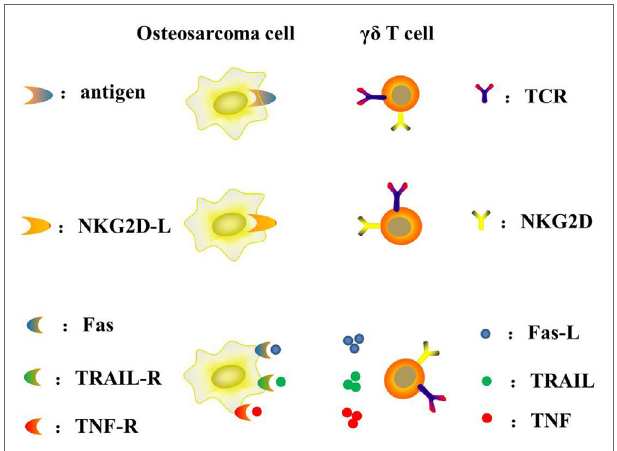
FiGURe 3 | Mechanism of γδ T cells recognizing and killing osteosarcoma cells